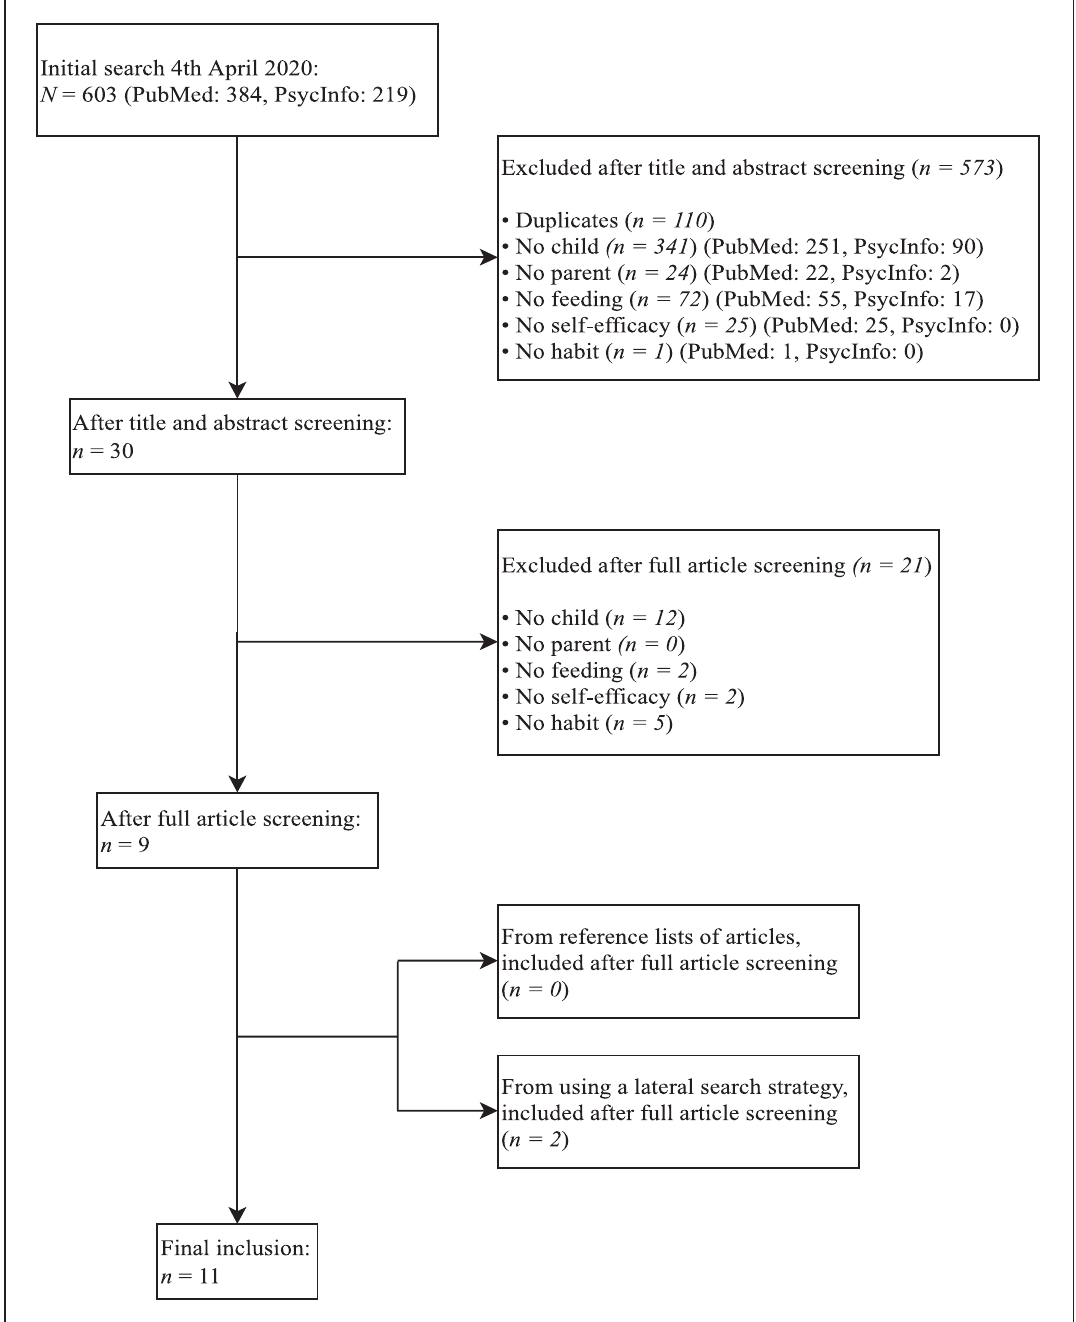
Figure 1 Flowchart Showing the Research